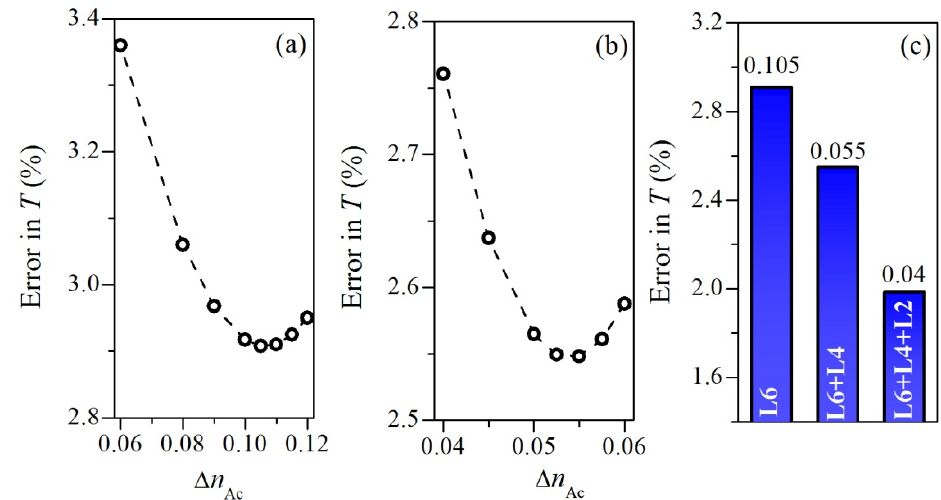
Figure 7. Dependence of fitting error on refractive index change ∆ n Ac generated by acetone vapor condensation in layer L6, which is closest to the air ( a ) and in L6 and L4 layers ( b ); Fitting error values obtained when calculating ∆ n Ac assuming vapor condensation in different porous layers in the stack denoted in the bars. The values indicate the calculated ∆ n Ac ((c)).